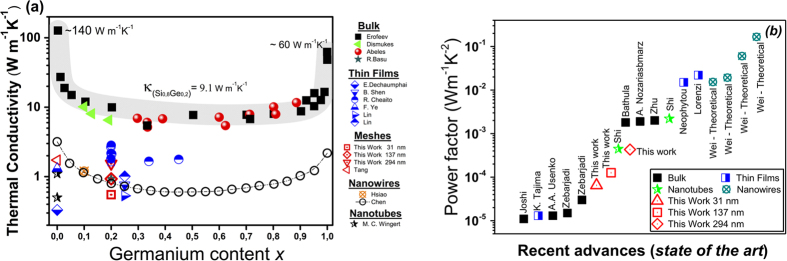
Literature reported (a) thermal conductivity values for Si-Ge structures versus germanium content3637394041435354808182 and (b) the state of the art of the power factor for Si0.8Ge0.2 structures.